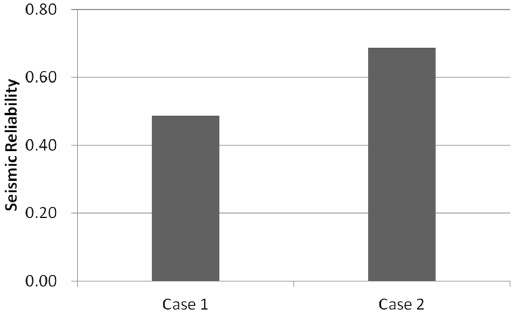
Figure 4. Maximum seismic reliability values of two case designs with different pipe sizing options.